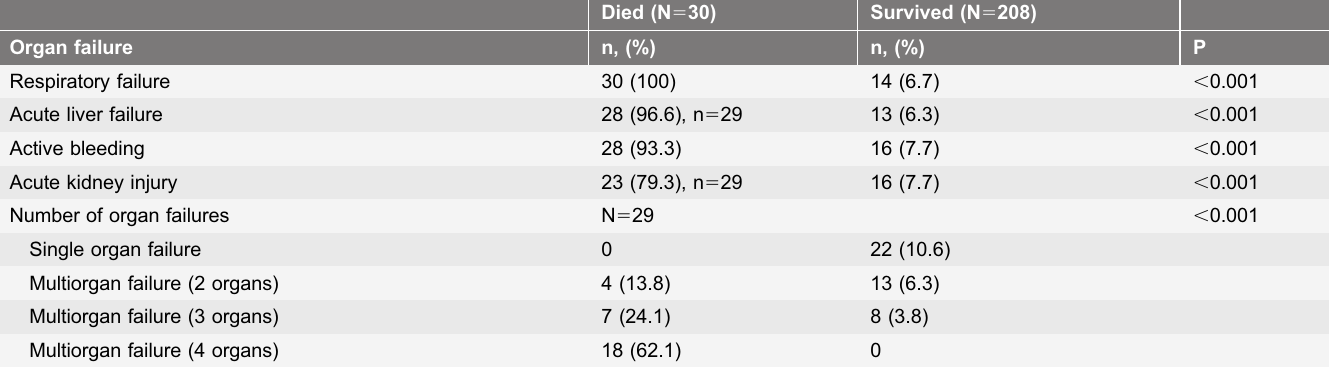
Table 2. Organ failure in severe DVI - a comparison between patients who died and patients who